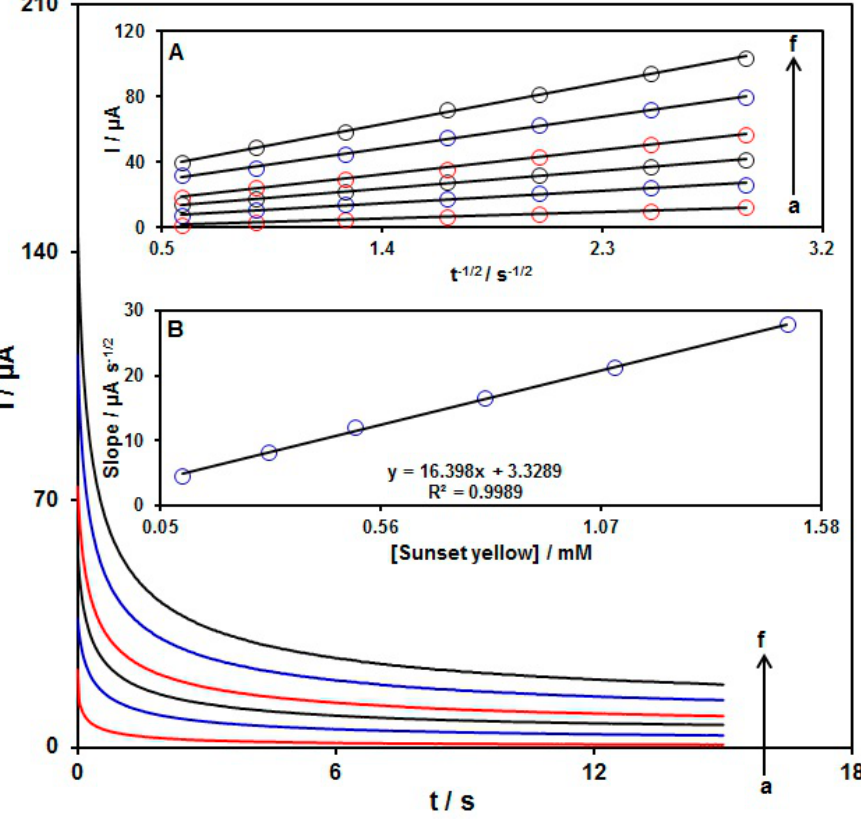
Figure 10. Chronoamperometric behavior of NiCo 2 O 4 /SPGE in PBS (0.1 M; pH = 7.0) at potential of 740 mV for variable sunset yellow contents (a: 0.1 mM, b: 0.3 mM, c: 0.5 mM, d: 0.8 mM, e: 1.1 mM and f: 1.5 mM). Insets: ( A ) Plots of I vs. t − 1/2 and ( B ) plots of the slopes from the straight lines vs. sunset yellow level.